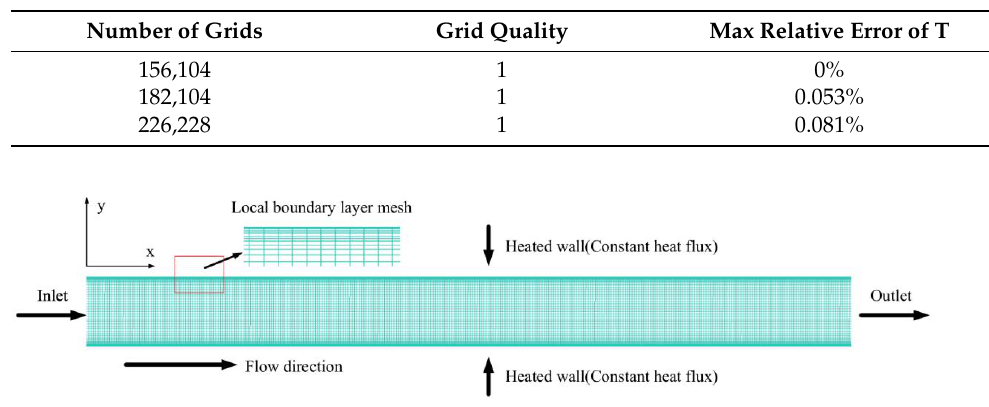
Table 5. Independent verification of grid size.